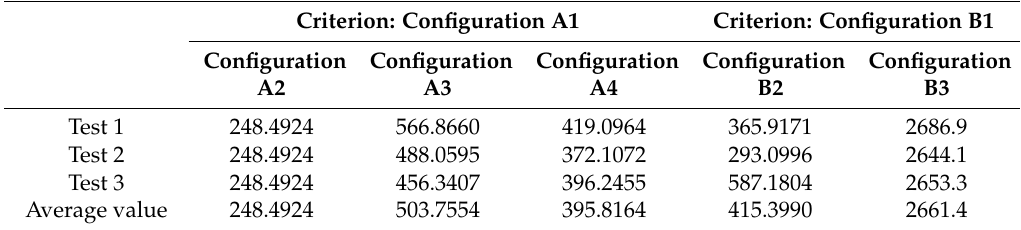
Table 11. The standard deviation of fuel cell power under different configurations (unit: W).